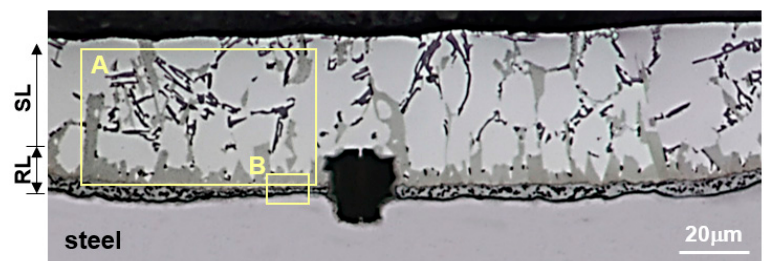
Figure 1 . Optical microstructure of specimen hot-dipped at 690 °C for 2 min.